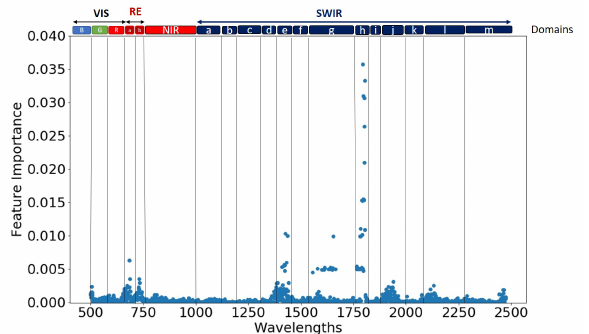
Figure 14. Feature importance (FI) calculated for each wavelength using the ExtraTrees Regressor method when considering the whole database. The spectral domains defined in Table 6 are reported above the graph. (RMSE = 0.25).